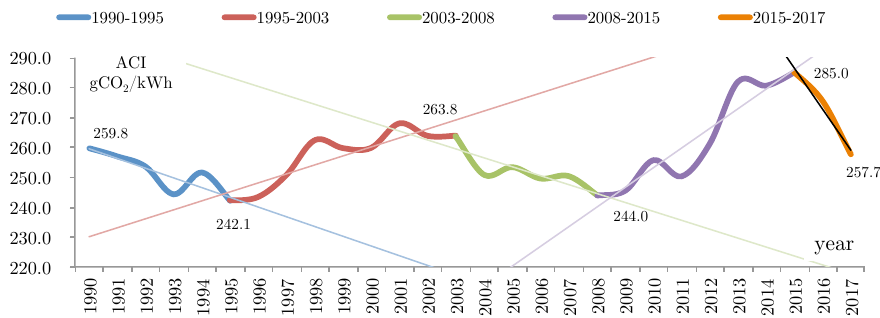
Figure 4. The aggregate carbon intensity of LAC countries,